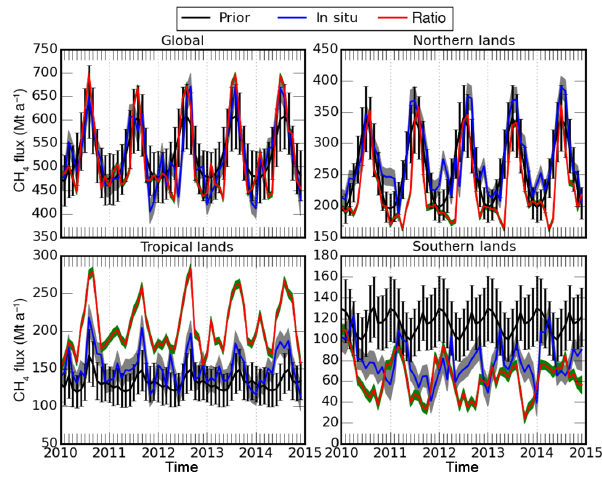
Figure 4. The same as Fig. 3 but for CH 4 fluxes.